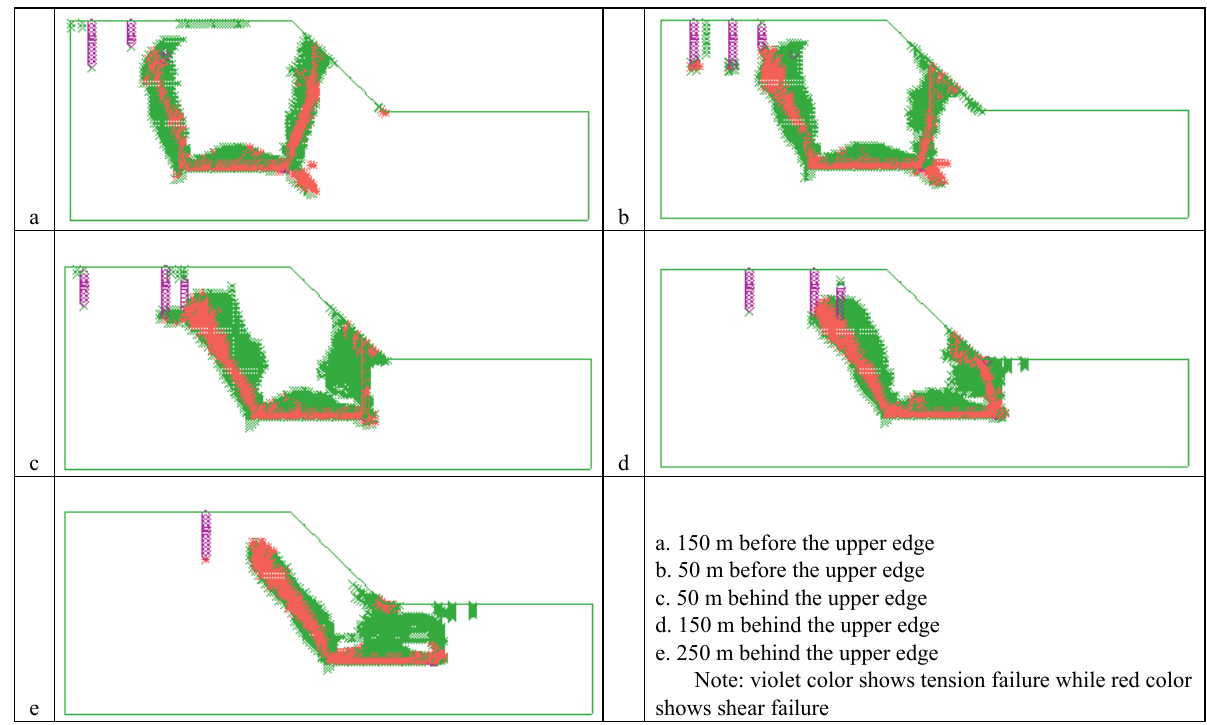
Fig. 12. Horizontal displacements of slope face at different positions of longwall panel (measured point is the center of the longwall panel)